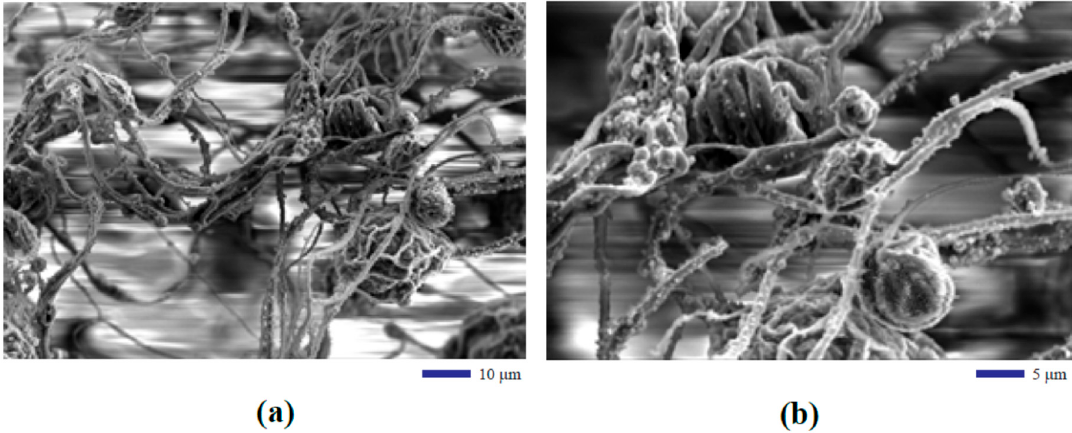
Figure 3. Scanning electron microscopic (SEM) analysis of the reaction spun composite fibers: ( a ) a lower magnification image showing the microfiber on the substrate; ( b ) a higher magnification image showing the titanium dioxide nanoparticles located at the surface of the carbon fibers.